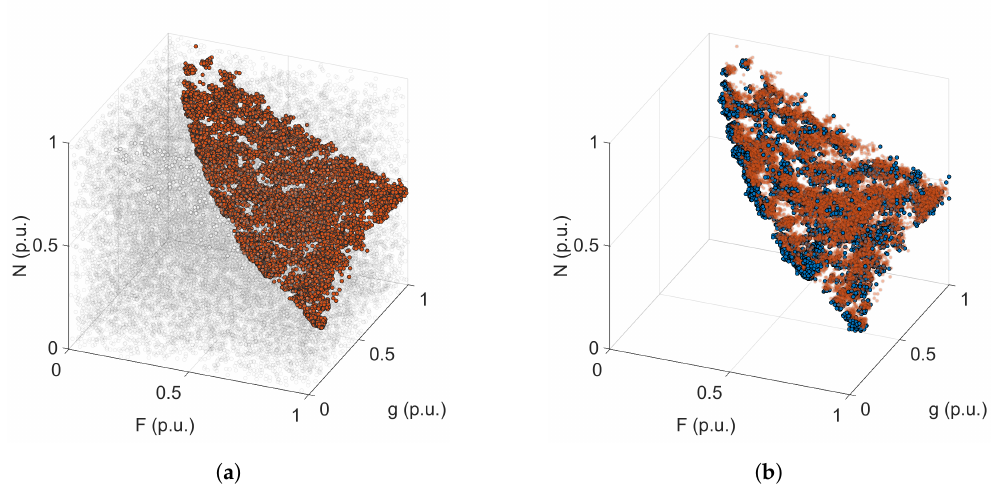
Figure 5. Representation in a design sub-space identified by the number of turns, the extension of the central column and the air gap length, of all the configurations explored during a run of the VIS multi-objective optimisation algorithm. All the feasible configurations (orange dots) are compared to ( a ) the unfeasible configurations generated randomly (grey dots); ( b ) the unfeasible solutions generated with local mutations (blue